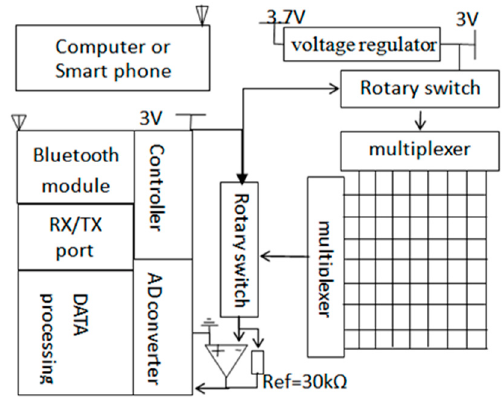
Figure 5. Data acquisition system.